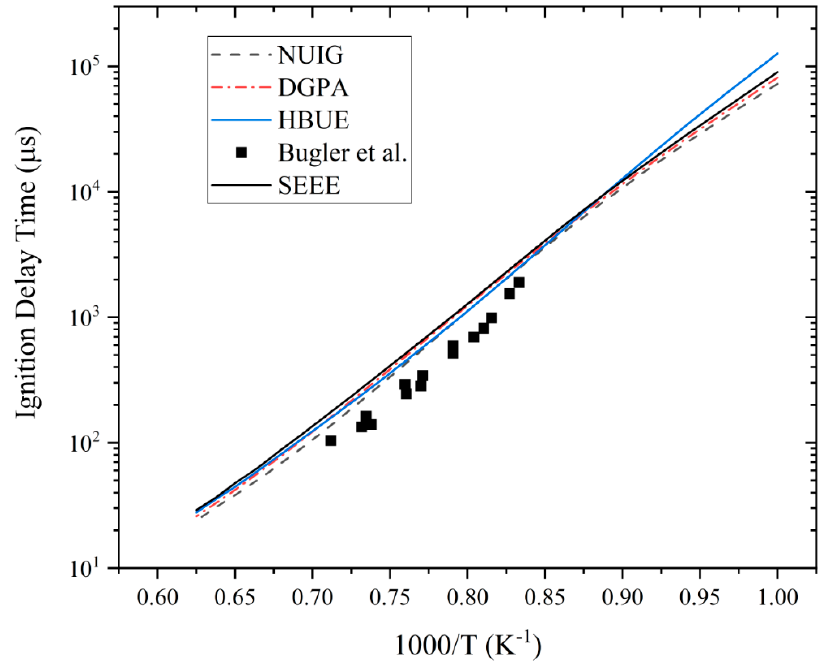
Figure 8. Comparison of the ignition delay times between NUIG, DGPA, HBUE, SEEE, and experimental data at an equivalence ratio of 0.5.